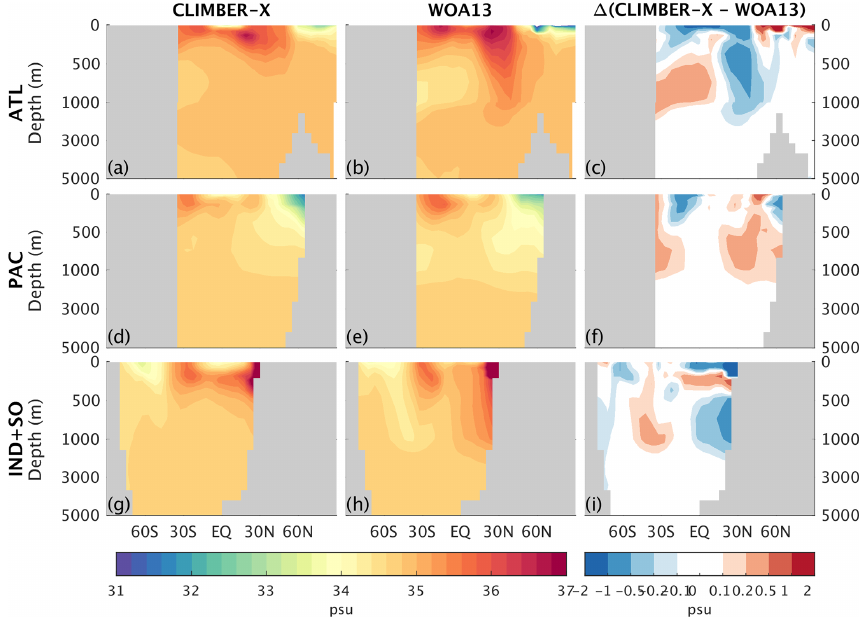
Figure 15. Zonal mean ocean salinity simulated by CLIMBER-X (a, d, g) compared to WOA13 data (Levitus et al., 2015) (b, e, h) for the (a, b, c) Atlantic, (d, e, f) Pacific, and (g, h, i) Indian and Southern oceans. The right panels show the model bias.